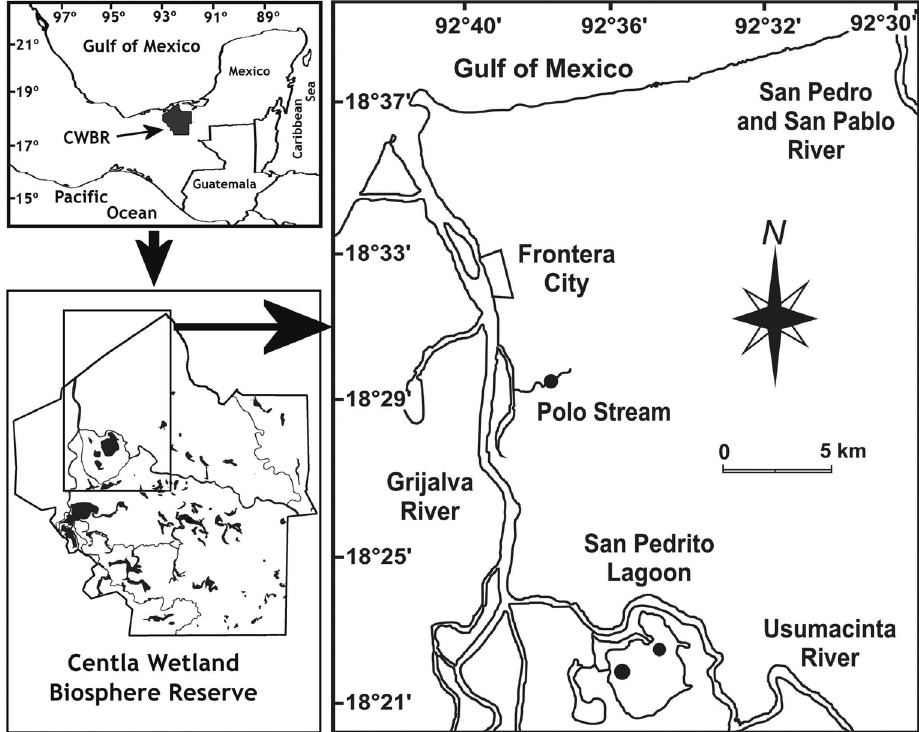
Fig. 1. Map depicting the location and extent of Centla Wetland Biosphere Reserve (CWBR) in Southern Mexico. The detailed study area map illustrates locations of field collections at Polo Stream and San Pedrito Lagoon along the Grijalva and Usumacinta Rivers in Tabasco,